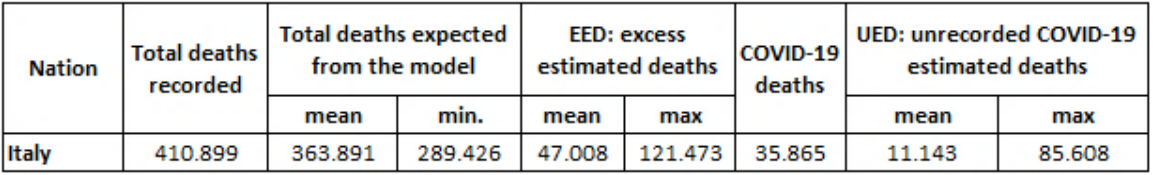
Table 4. Results obtained from the analysis of Italian deaths (reference period March-September